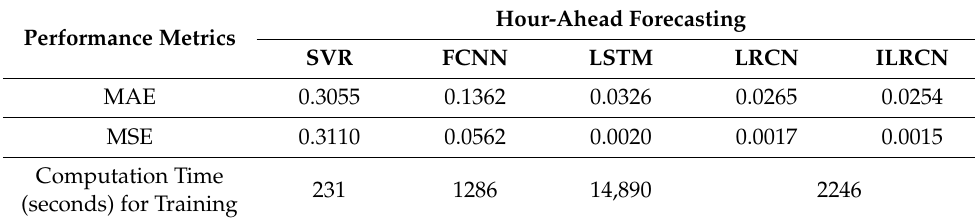
Table 4. Performance metrics of different models for hour-ahead forecasting. Performance Metrics